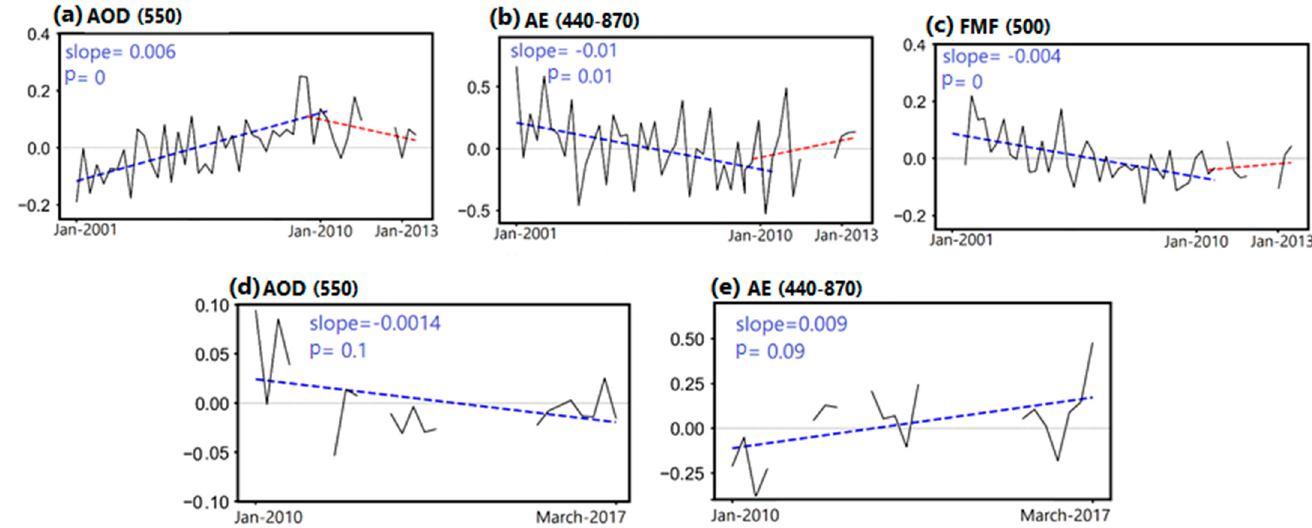
Figure 5. Deseasonalized trends in AOD ( a ), AE ( b ), and FMF ( c ) during winter at the Solar Village AERONET site over the period 2001–2013. Similar trends for AOD ( d ) and AE ( e ) during winter at the IABAS AERONET site over the period 2010–2017.